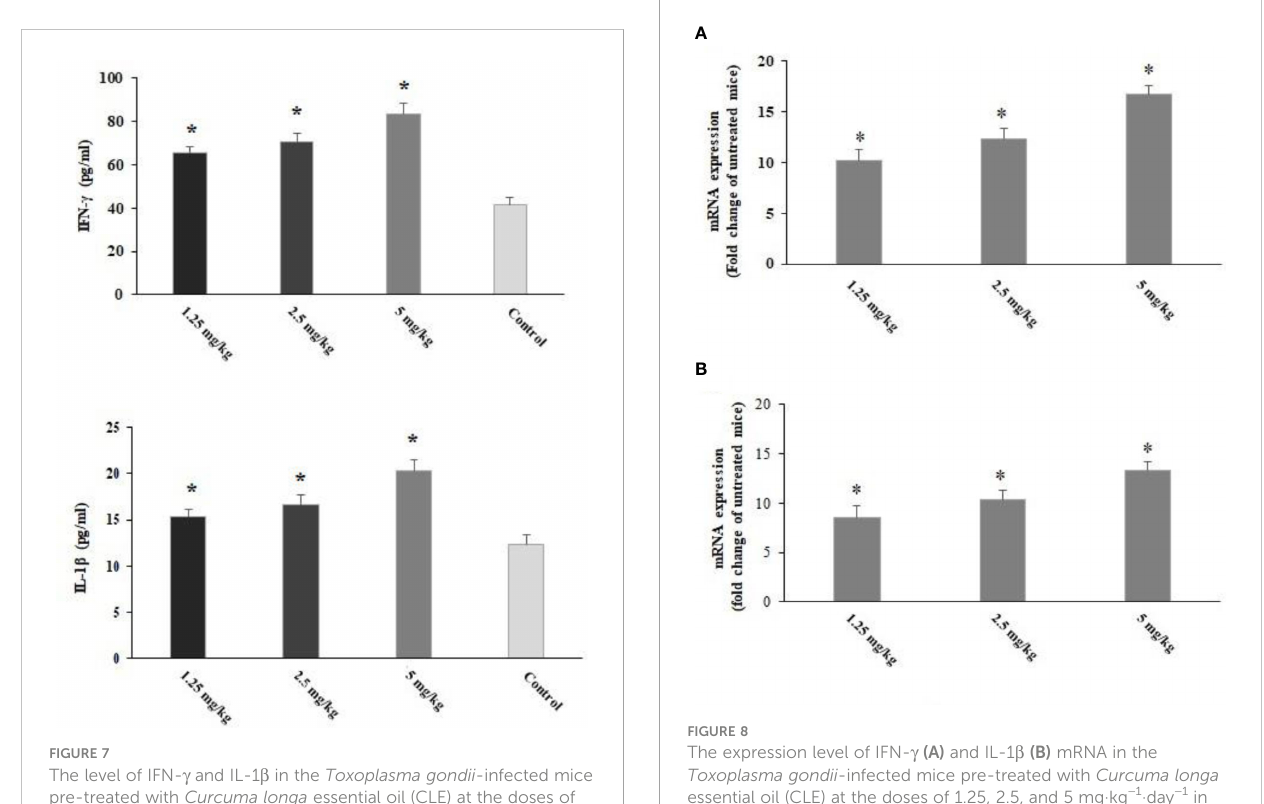
vivo assay, the infected mice pre-treated with CLE at 1.25, 2.5, and 5 mg·kg − 1 ·day − 1 for 2 weeks showed an increased survival rate and fewer peritoneal parasites.